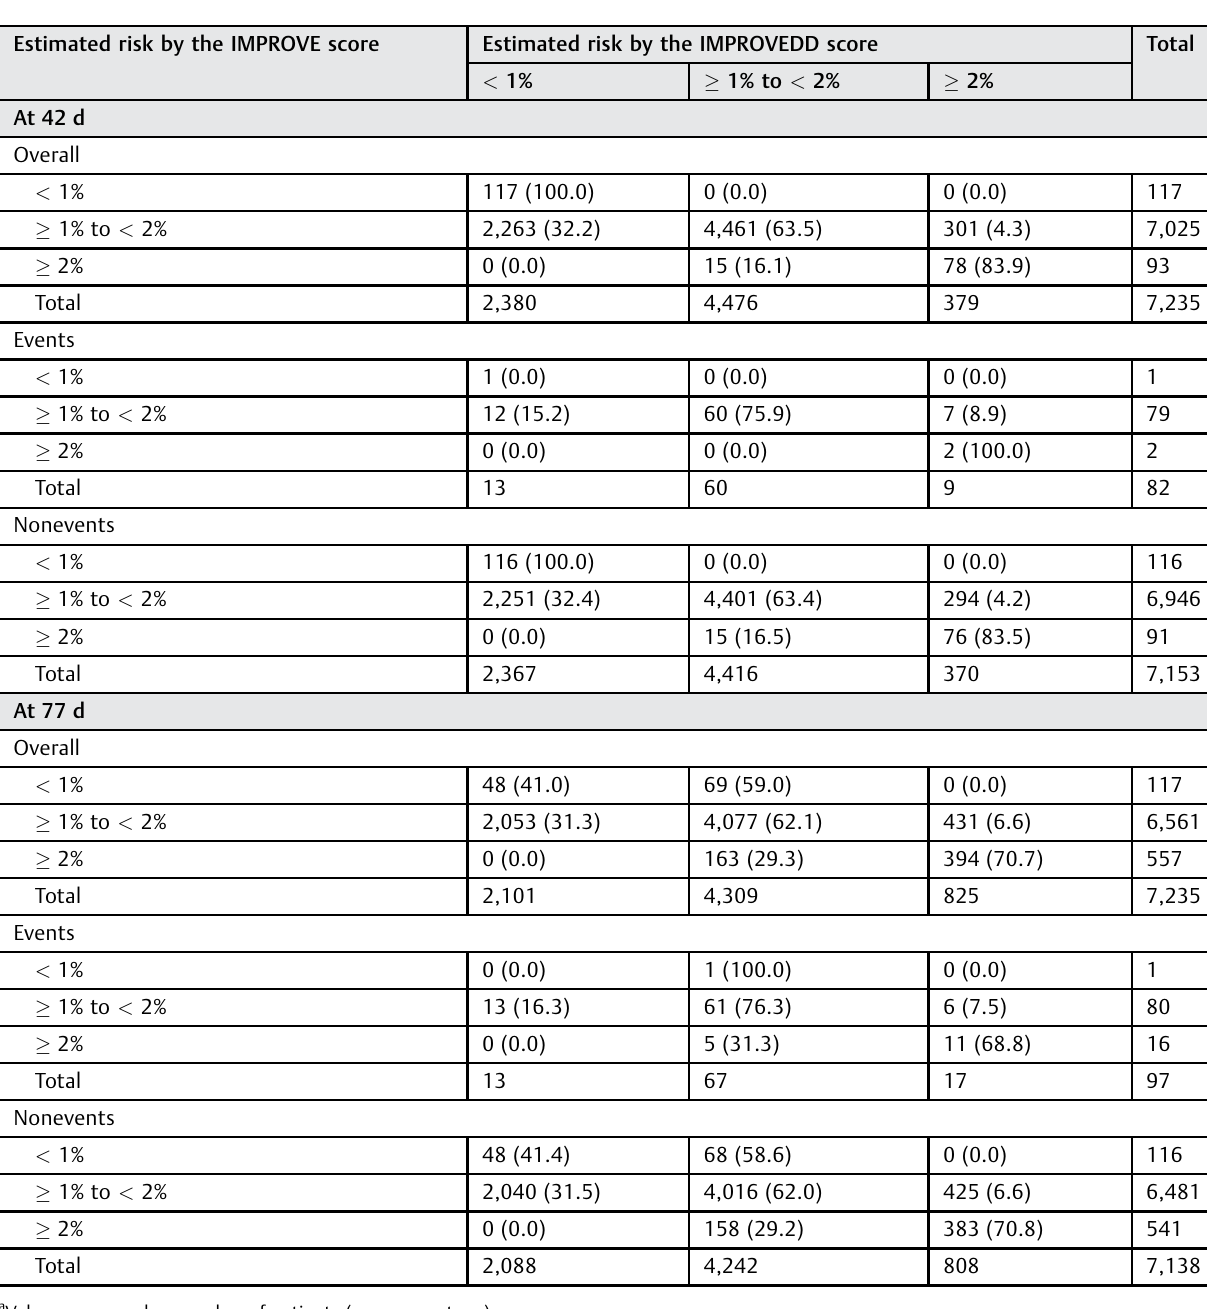
Table 5 Reclassi fi cation by the IMPROVEDD VTE risk score a